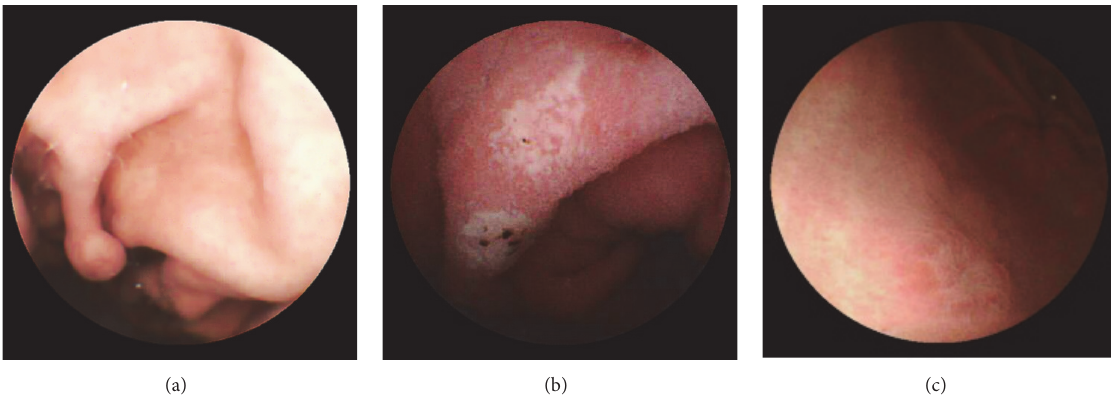
Figure 3: Positive findings in the stomach from different body positions. (a) A polyp located in the gastric body from Su position. (b) Multiple ulcers located in the antrum from R position. (c) An ulcer located in the antrum from Si position. L: left lateral; Su: supine; R: right lateral; KC: knee-chest; Si: